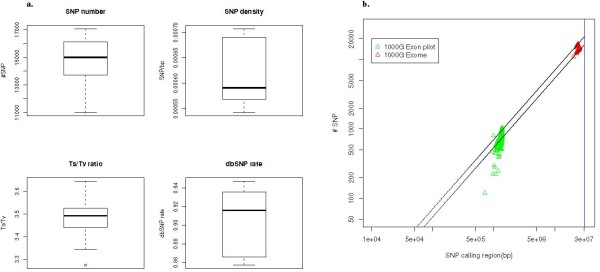
SNP Call Metrics. (a) SNP metrics of 92 1000 Genomes exome samples. The four figures are SNP number, Ts/Tv, dbSNP% and SNP density distributions respectively. SNPs were called and compared in the callable region with a variant read depth of at least 2. Previous studies have indicated that coding SNPs should have a Ts/Tv ratio of 3-4 [15]. (b) SNP density in the 1000 Genomes Exome Project vs. the Exon Pilot. The SNP density was calculated as the number of SNPs discovered in each sample normalized against their callable region. The maximum and minimum SNP density in the 1000 Genomes exome data are 0.70/Kbp and 0.54/Kbp respectively, which are presented as two slope lines in the figure.